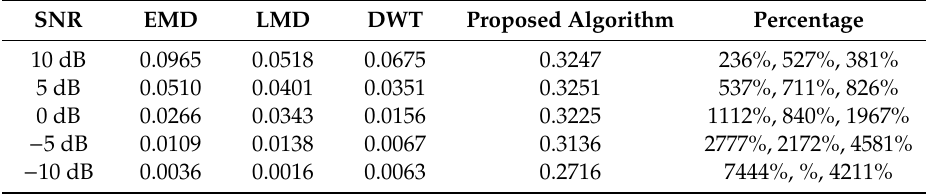
Table 4. The amplitude value of first-order frequency for di ff erent analysis methods and